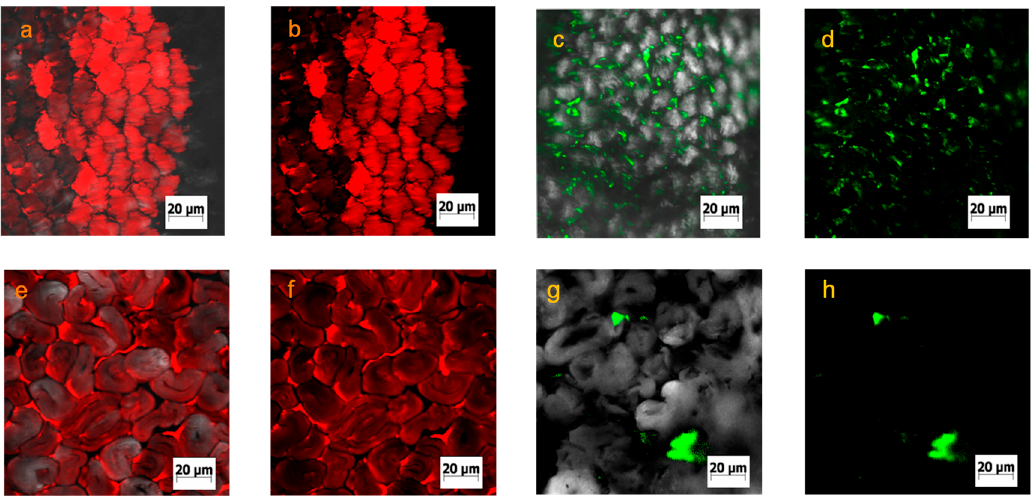
Figure 5. Confocal fluorescence images of distribution of water ( a , b , e , f ) and siloxane ( c , d , g , h ) medium in viscose ( a , b , c , d ) and cotton ( e , f , g , h ) fiber; the merged channel ( a , c , e , g ) and the laser channel ( b , d , f , h ).